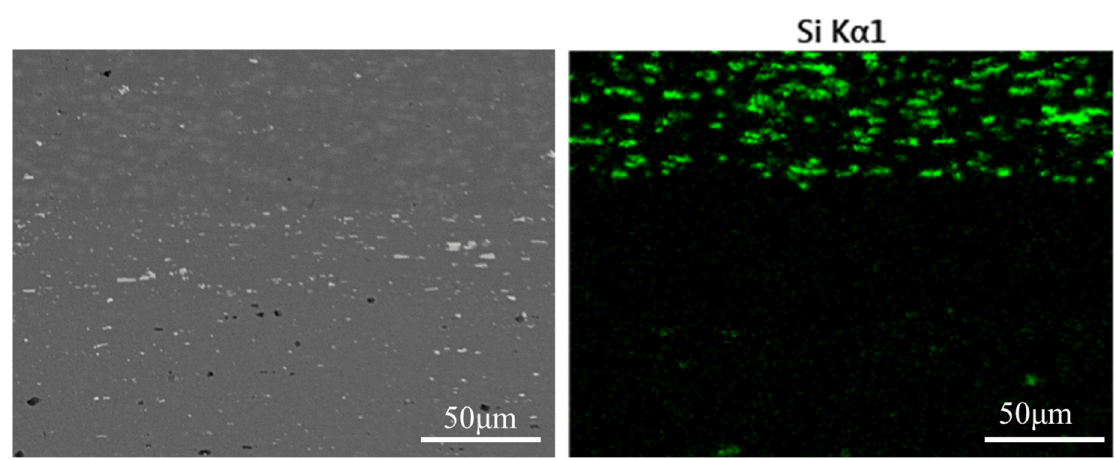
Figure 5. Si particles in clad layer (4343).